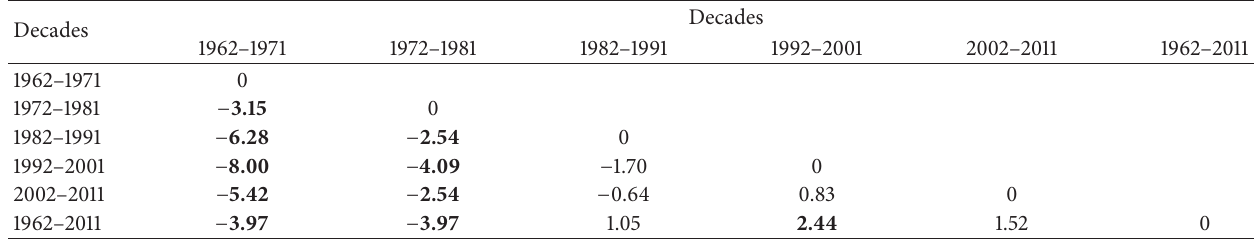
Table 3: Comparisons between the mean annual temperature of a given decade and the following decades or the entire period by using the Student’s 𝑡 -test.